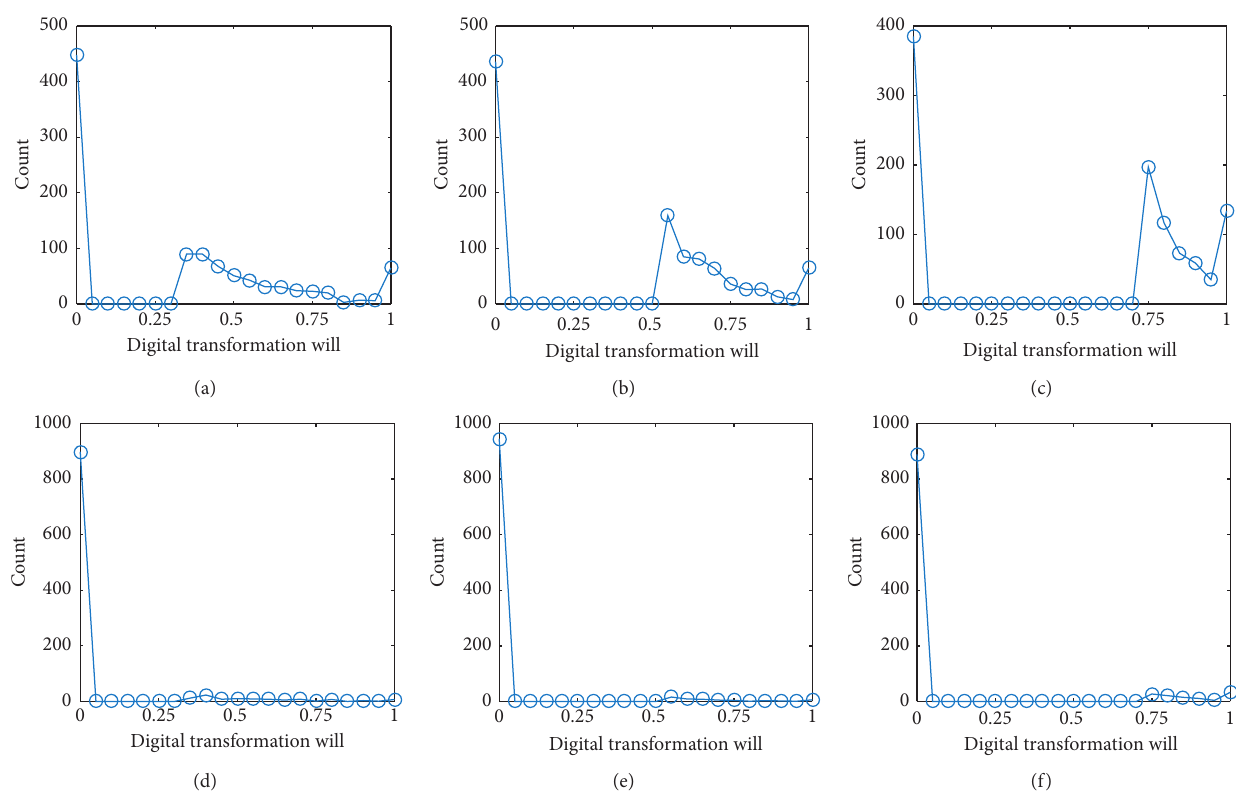
Figure 6: Enterprises’ transformation willingness under different demand-side policies: (a) p1 � 0.3, Cu � 1, Cb � 2; (b) p 1 � 0.5, Cu � 1, Cb � 2; (c) p 1 � 0.7, Cu � 1, Cb � 2; (d) p 1 � 0.3, Cu � 2, Cb � 4; (e) p 1 � 0.5, Cu � 2, Cb � 4; (f) p 1 � 0.7, Cu � 2, Cb �